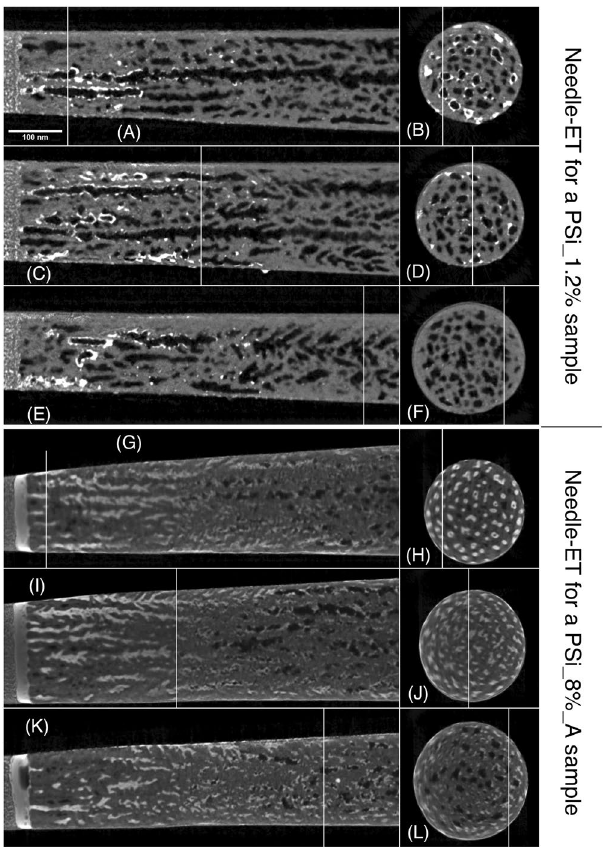
Figure 4. Needle-ET of PSi:Er samples. Panels (A) to (F) refer to a PSi_1.2% sample, while panels ( G ) to ( L) refer to a PSi_8%_A sample. Panels (A), (C), (E), (G), (I) and (K) are different sagittal slices, while ( B ), ( D ), ( F ), ( H ), ( J ) and ( L ) are different axial slices in the 3D reconstructed volume. Localization of the sagittal slices are represented by a white line on the corresponding axial slices and vice versa. The surface of PSi specimen for both samples is on the left hand side of the figure. The surface of the original PSi specimen is visible on the extreme left part of the figure. The filling of the pores by the Er deposition is evidenced by the white signal from the PSi pores. A detailed description of the figure is in the